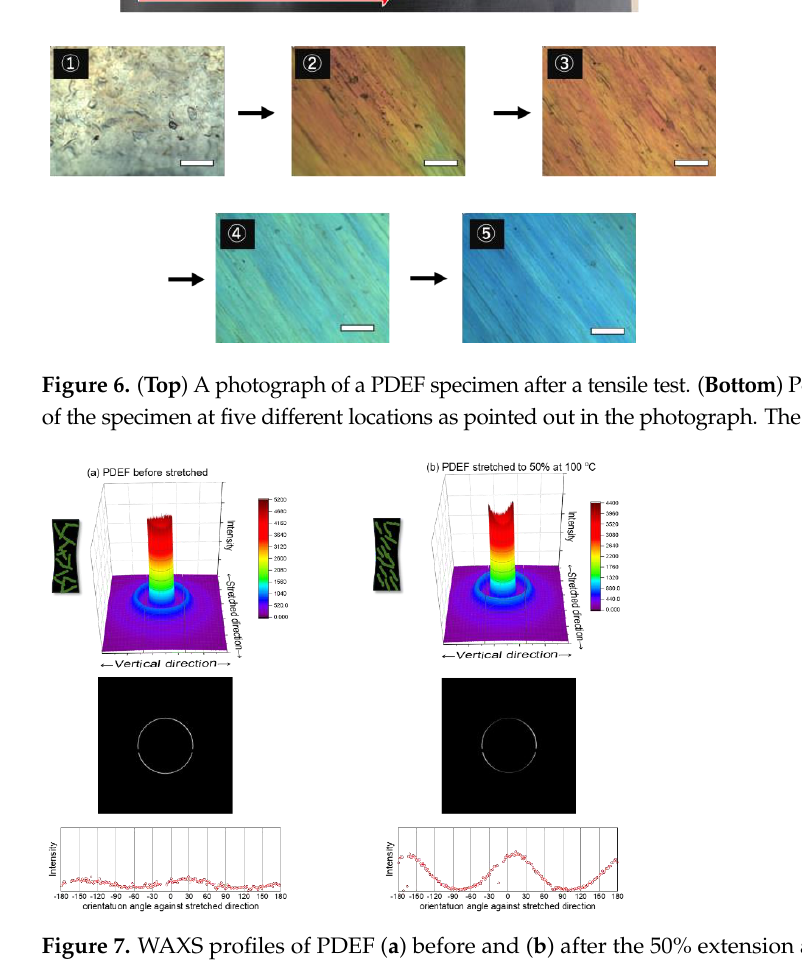
Figure 8. WAXS profile of PDEF after extension at 100 °C for 50%, 150%, and 1500%. The q value ranging from 4 to 12 nm −1 is presented. The peak of the amorphous halo at q = 6.5 nm −1 starts to split after extension. Our data support that the two thermal anomalies of PDEF observed in DSC meas- urement correspond to β relaxation and α relaxation rather than two T g s. Therefore, at the temperature range between β relaxation and α relaxation, PDEF is still brittle and re- sponds elastically upon extension. The strong β relaxation is likely to be linked to the amorphous peak at q = 6.5 nm −1 . Due to the rod-like nature of the poly(fumarate)s, it be- haves similarly to the main chain liquid crystalline polymers. A possible scenario is as follows. Above β relaxation temperature, the side chain cannot fully rotate along the main chain. Hence, the material does not flow upon extension. Nevertheless, the side chain starts to rattle at β relaxation. This rattle weakens the amorphous packing. As a result, the storage modulus decreases, and heat capacity changes. The rotation of the side chain